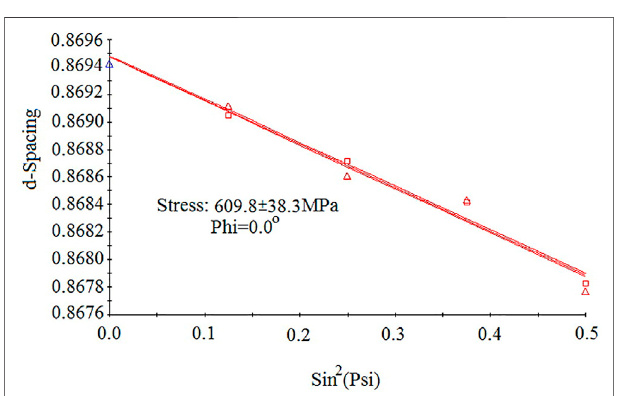
FIGURE 9 | d – sin2 ψ diagram for sample